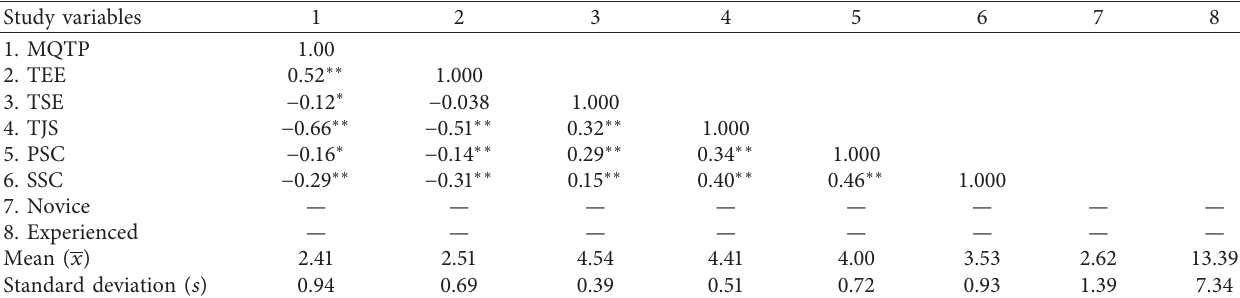
Table 2: Zero-order correlations and descriptive statistics of the study